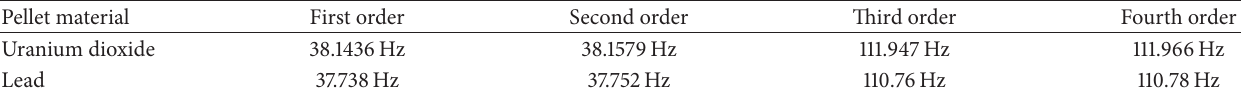
Table 1: Natural frequency of the fuel rod.